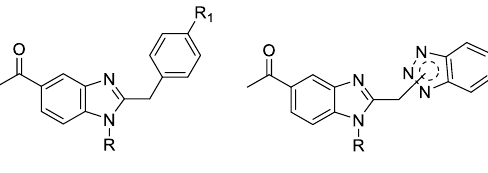
Figure 2. Scaffold structures of our Series 1 (5-acetyl substituted 2-benzylbenzimidazoles) and Series 2 (2-[(benzotriazol-1/2-yl)methyl]benzimidazoles), which we previously reported as antiviral agents.